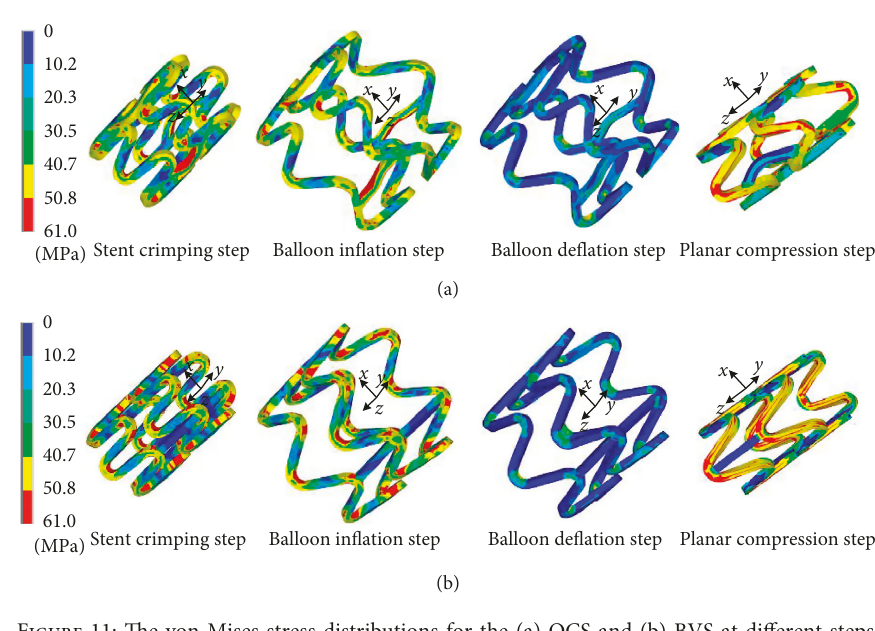
Figure 11: The von Mises stress distributions for the (a) OCS and (b) BVS at different